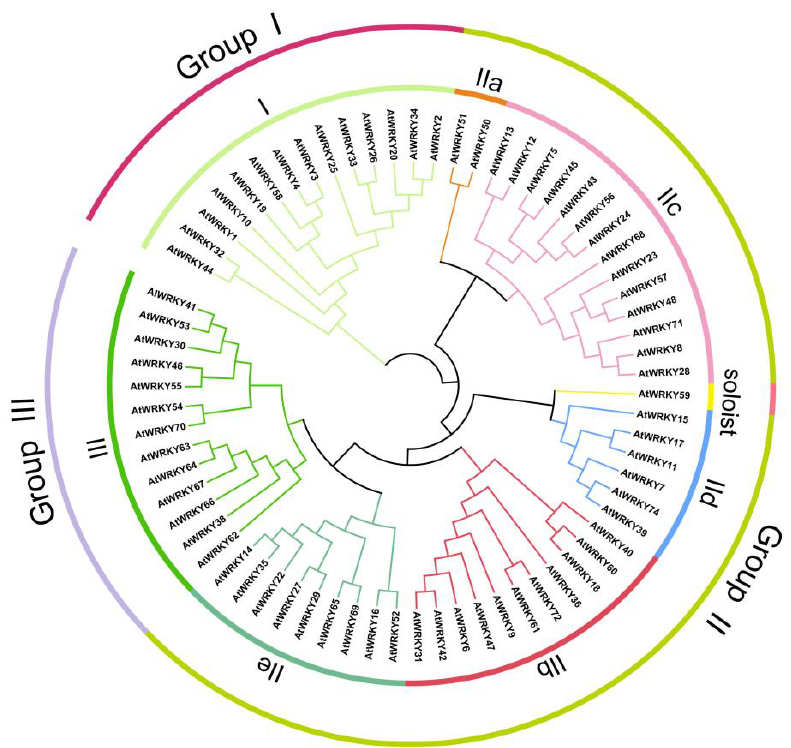
Figure 2. Arabidopsis WRKY gene family phylogenetic tree.